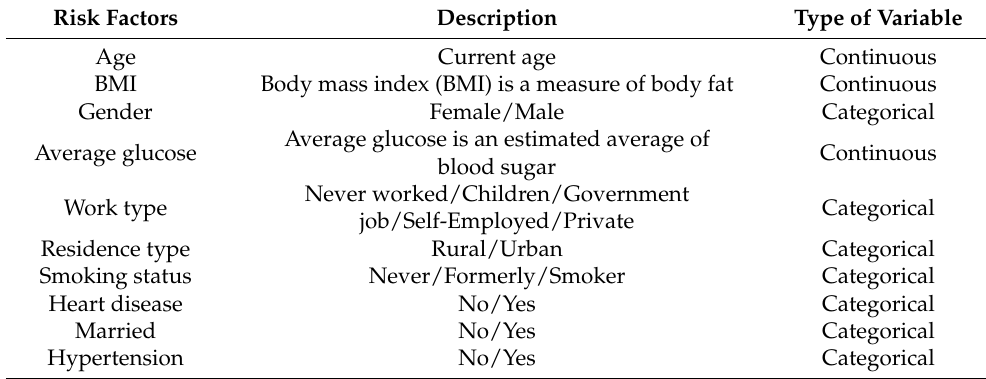
Table 1. Included risk factors.